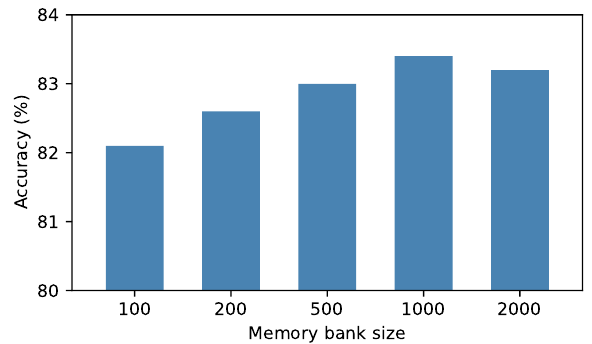
Figure 4. The impact of the memory bank size on